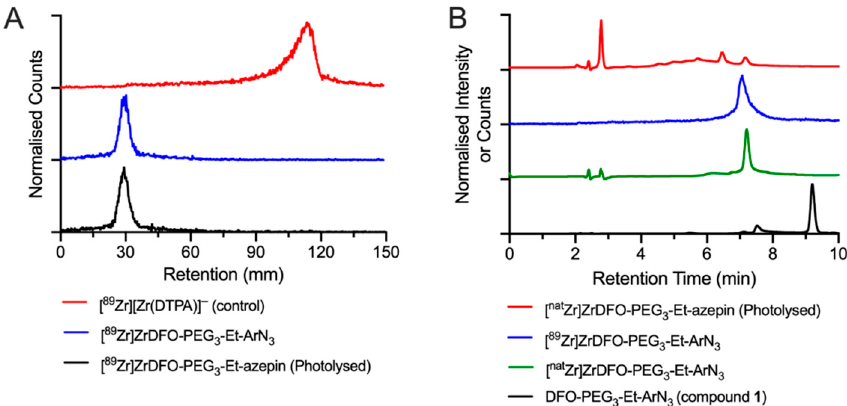
Figure 3. Radioactive chromatography: ( A ) Radio-ITLC chromatograms of [ 89 Zr]ZrDFO-PEG 3 -Et- ArN 3 before (blue) and after (black) photolysis at 395 nm. The elution profile of [ 89 Zr][Zr(DTPA)] – (red) is shown as a control. ( B ) HPLC chromatograms show the elution profiles of compound 1 (black); the non-radioactive [ nat Zr]Zr-complexes before (green) and after (red) photolysis; and the [ 89 Zr]ZrDFO-PEG 3 -Et-ArN 3 complex (blue).